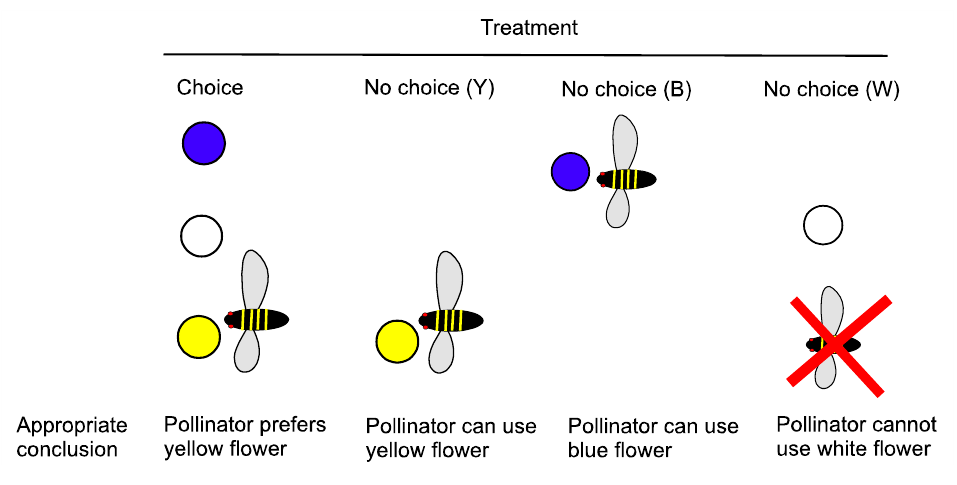
F IGURE 3. A simple choice/no choice experiment with four treatments. The pollinator is offered yellow (Y), blue (B), and white (W) flowers. This pollinator visits yellow flowers when all flowers are available. It could survive in the absence of yellow flowers IF blue flowers are available, but could not survive if only white flowers are